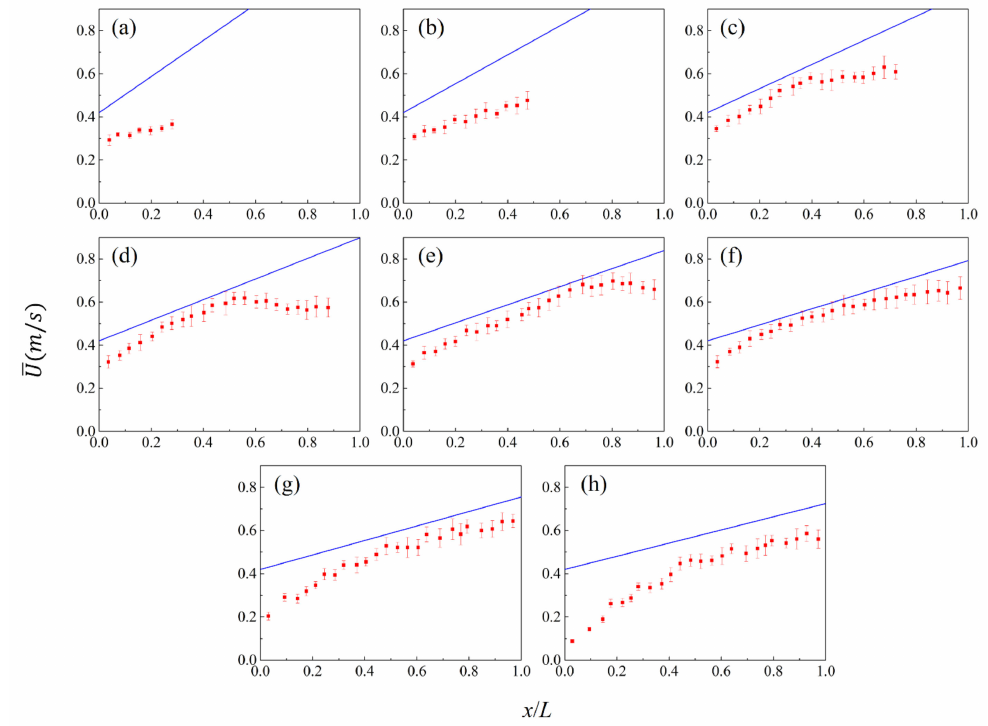
Figure 12. Comparisons of measured velocities and Ritter’s solution above the plate for case 1. Red dot: measured depth–averaged velocity, blue line: Ritter’s solution: T = ( a ) 0.35; ( b ) 0.43; ( c ) 0.52; ( d ) 0.61; ( e ) 0.69; ( f ) 0.78; ( g ) 0.87; and ( h )